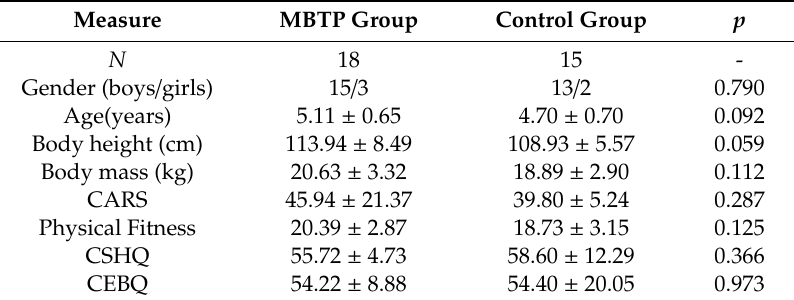
Table 1. Baseline characteristics of participants (M ± standard deviation (SD)).